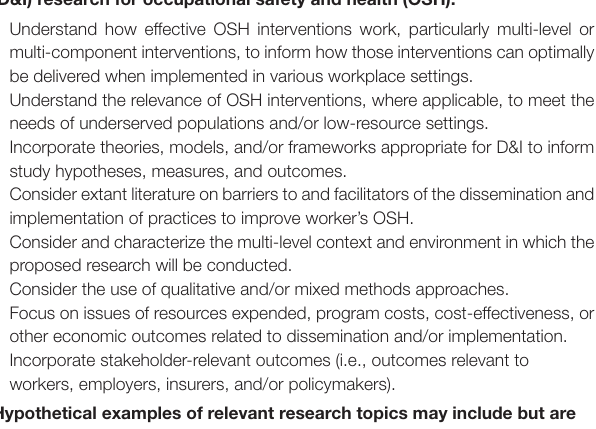
TABLE 1 | Ideas for advancing dissemination and implementation science in occupational safety and health. Key characteristics to consider for dissemination and implementation (D&I) research for occupational safety and health (OSH):